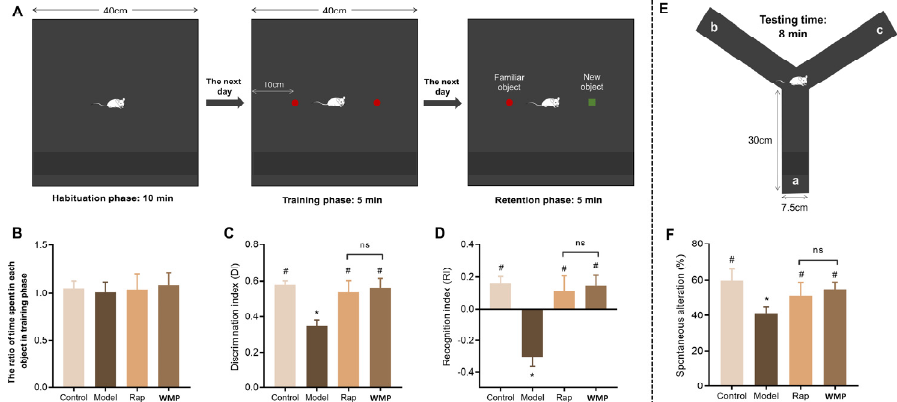
Figure 3. The effects of WMP on short-term spatial and recognition memory of mice. ( A ) Schematic representation of NORT, ( B – D ) The ratio of time spent in exploring each object in the training phase, DI and RI, respectively, ( E ) Schematic representation of the YMT, ( F ) Spontaneous alteration (%). * p < 0.05 vs control group and # p < 0.05 vs model group; ns: not significant. Y-maze test (YMT). The YMT is a quick and easy spatial memory test that can be reflected by the natural tendency to spontaneously choose alternate arms in the maze